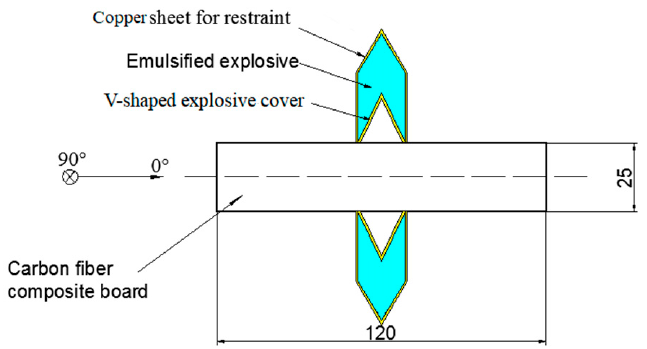
Figure 2. Schematic diagram of shaped energy jet cutting.